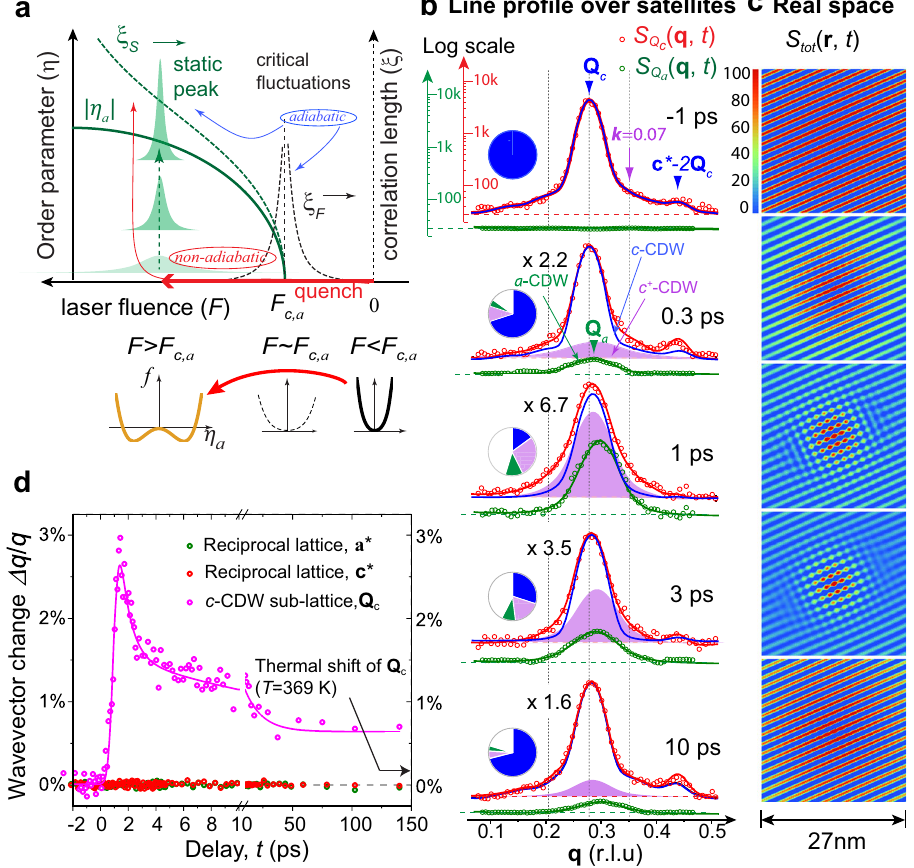
Fig. 4 Evolutions and re fi nements of the CDW parameters. a Schematic depiction of coarsening dynamics (in green) manifested in the structure factor of the a -CDW state. The dynamics is driven by an interaction quench of control parameter, here expressed in fl uence F , across the critical point, F c,a . The nonadiabatic growth both in the order parameter amplitude, | η a |, and in the growth of the correlation length, ξ a , as re fl ected in the sharpening of diffraction width, is a different behavior from that of a near-equilibrium route, in which the change in structure factor adiabatically follows the change of control parameter. The critical fl uctuations are manifested in the divergence of correlation length, ξ F , near F c,a . The free-energy landscapes of the initial state, at the critical point, and the fi nal state are plotted below. b Structure factor evolution at F = 1.85 mJ/cm 2 , taken along a - and c -CDW satellites. Note here the semi-log scale to highlight the signals near the diffusive fl oor where a weak second-order satellite peak at c * − 2 Q c is also identi fi ed. The data (in symbols) are fi tted with the theoretical structure factor pro fi les (in line), deduced through Fast Fourier Transform analyses from an interactive structure re fi nement protocol to construct the autocorrelation function of the system, S tot ( r , t ), based on the fi tting; see Supplementary Note 2. The pie charts (same color codes as in Fig. 3b) indicate the relative scattering weight from each CDW component during evolution. c The corresponding S tot ( r , t ), deduced from fi tting the experimental S Ql ( q , t ) in b . d The momentum wavevector changes obtained for the 2D atomic lattice and the c -CDW super-lattice. For the former, the changes are from the lattice Bragg peaks at Q 600 and Q 006 . For the latter, the mean wavevector (cid:2) Q c is calculated by integrating the scattering weight across the S Qc ( q , t ) line pro fi le as shown in b